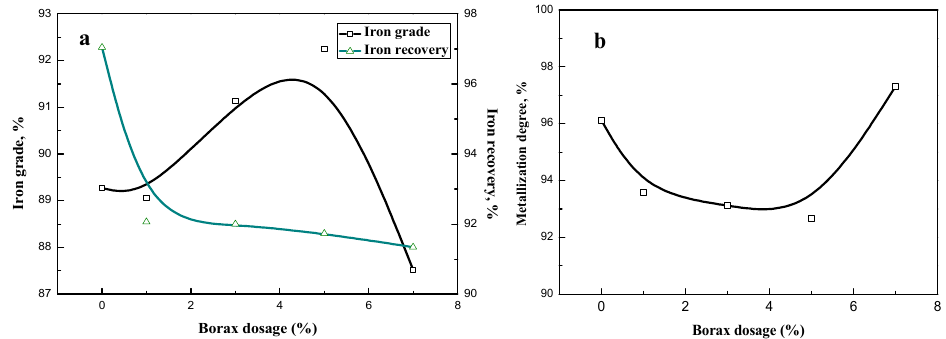
Figure 1. Effect of borax dosage on iron grade and iron recovery of magnetic concentrate ( a ), and effect of borax dosage on metallization degree of reduced briquettes ( b ) (reducing at 1050 °C for 80 min, and grinding fineness (<0.044 mm) exceeding 68%).